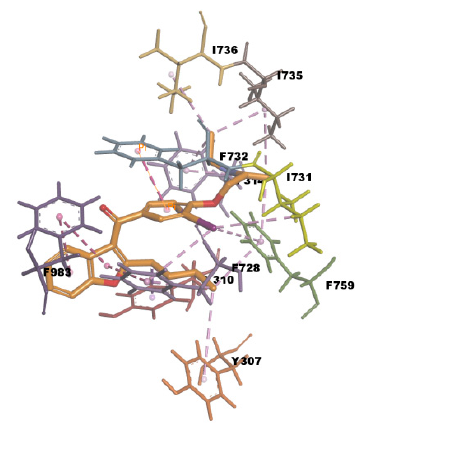
( b ) Figure 13. Digoxine (DIG) top-ranked pose obtained with CDOCKER algorithm. ( a ) 3D view of DIG interactions in the binding pocket. Green dotted lines represent conventional hydrogen bond interactions and light-rose dotted lines represent hydrophobic interactions. Residues Q725, Q990, and F728 involved in hydrogen bond interactions are colored yellow; ( b ) 2D interaction diagram of DIG with h P-gp interacting residues. The green dotted lines represent conventional hydrogen bond interactions. The light-green dotted line represents a π –donor hydrogen bond interaction. AM docked pose, shown in Figure 14, presents many hydrophobic interactions involving ten residues in the binding pocket (Y307, Y310, F314, F728, I731, F732, I735, I736, F759, and F983), among them many π –alkyl type of interactions but also π –sigma and π – π type of interactions. The estimated binding energy is favorable but of smaller magnitude compared with CsA or RMP values. The difference in the binding energies could be explained by the lower number of hydrogen bonds in the binding mode; there is only one weak carbon hydrogen bond type of interaction C–H…O with the residue I731. This is also the case of LPM, which shows hydrophobic interactions with nine residues in the binding pocket (L762, F732, Y307, Y310, F728, F759, L339, I340, and F314) but just one weak carbon hydrogen bond type of interaction with the residue F728 (Figure 15). The calculated binding